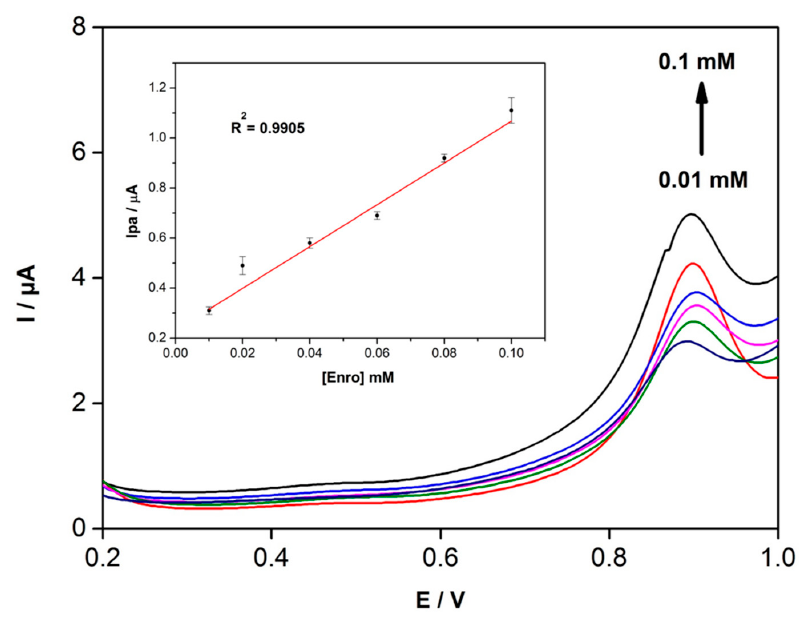
Figure 7. Square wave voltammetry (SWV) to MIP-electrode in the presence of enrofloxacin at different concentrations in buffer solution pH 3.